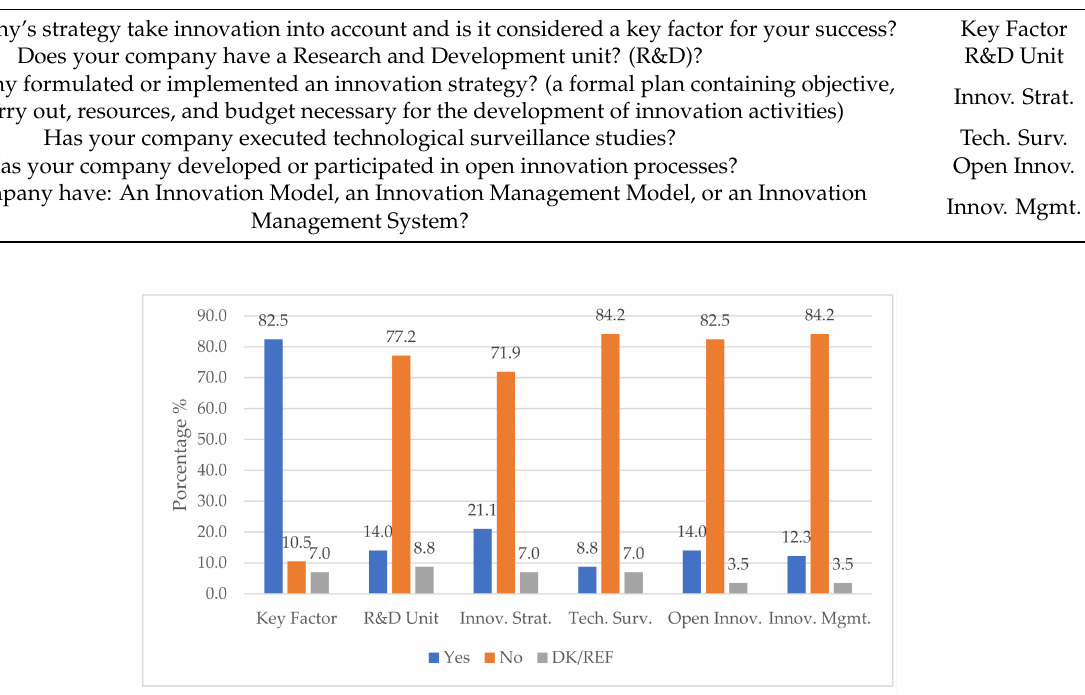
Figure 7. Results of the companies surveyed in relation to their innovation general